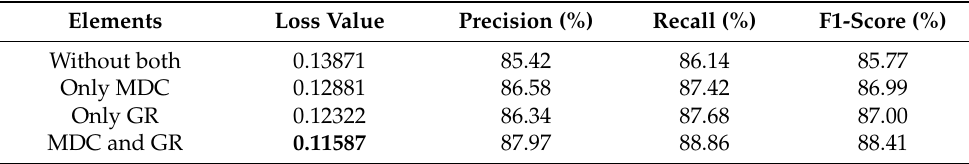
Table 4. The results of ablation experiments. The values in bold are the best. Elements